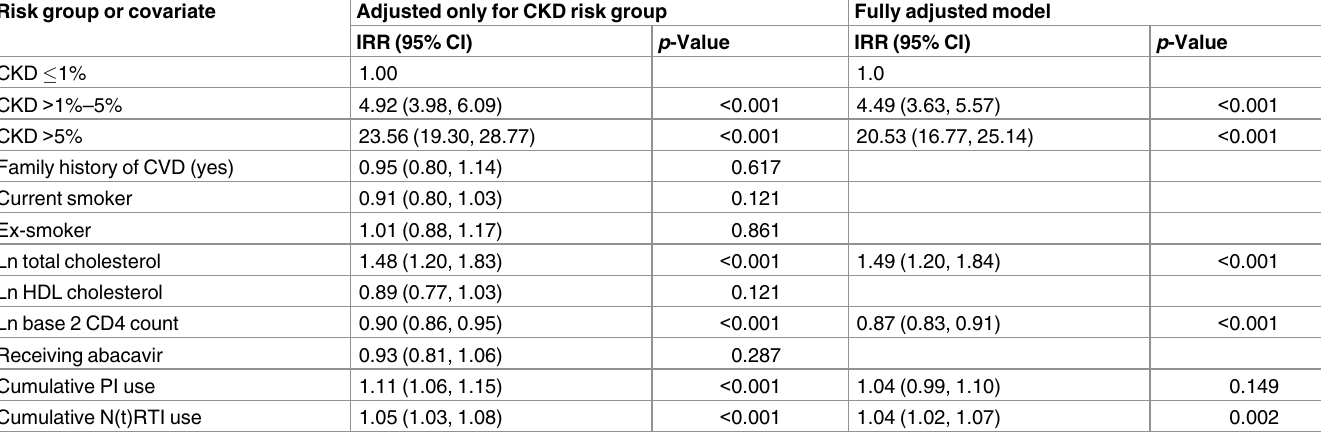
Table 4. Covariatesof CVD risk score as predictors for CKD events adjusted for CKD risk group.